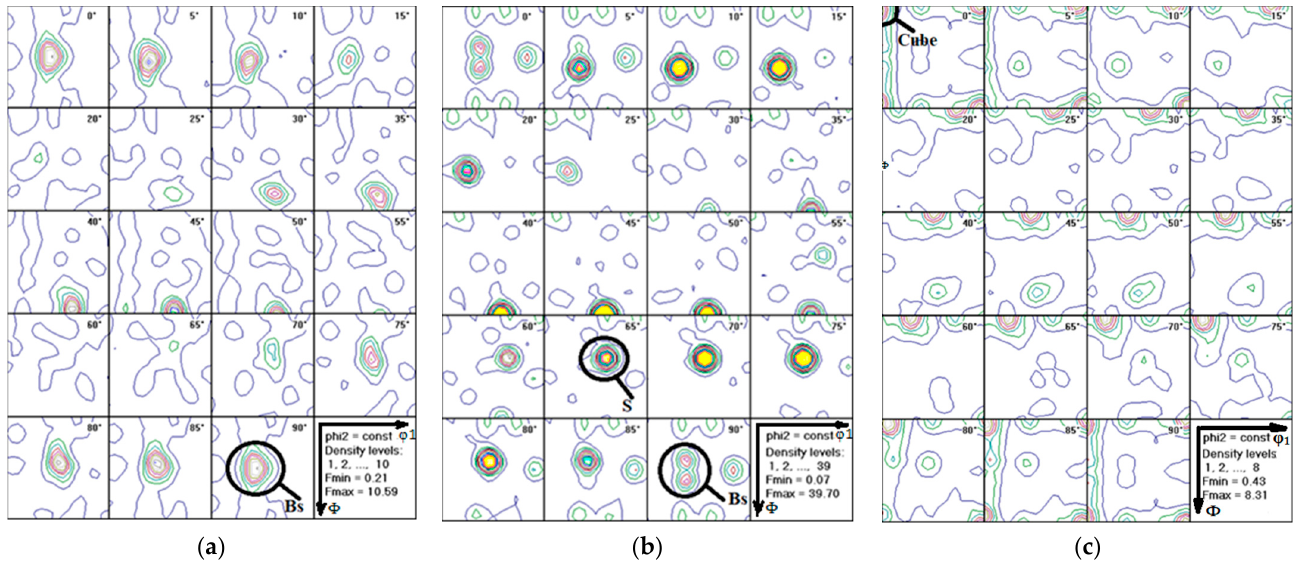
Figure 14. Results of X-ray structural analysis (ODF data). ( a ) before the second stand, ( b ) after the fifth stand, ( c ) after self-annealing.